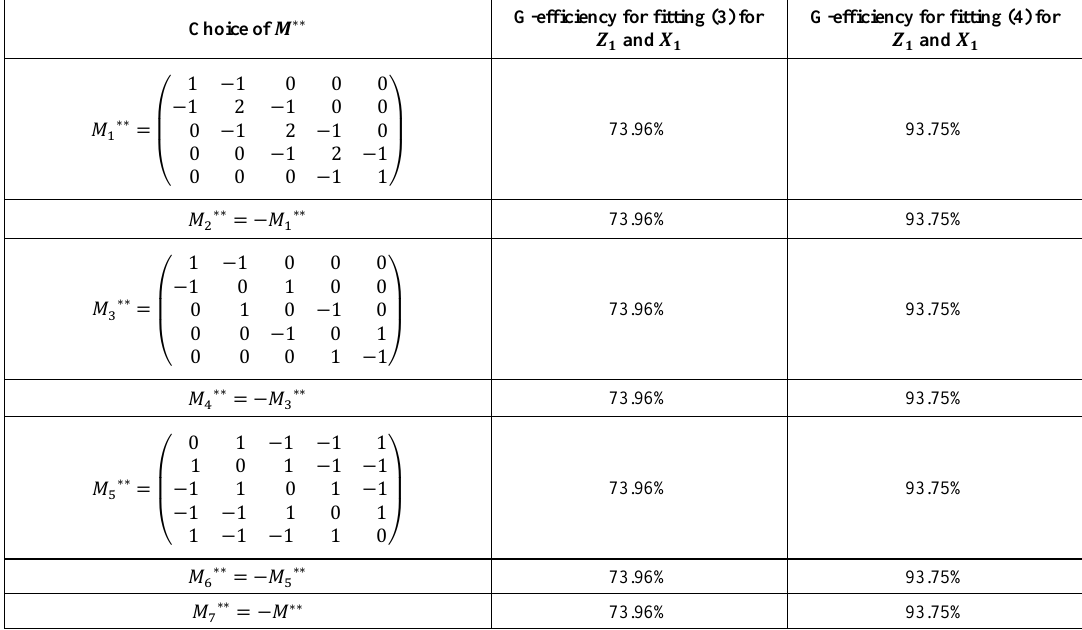
Table 3. G-efficiency of unconstrained and constrained mixture designs corresponding to different choices of 𝑀 ∗∗ for fitting Scheffé’s canonical polynomials G-efficiency for fitting (3) for G-efficiency for fitting (4) for Choice of 𝑴 ∗∗ 𝒁 𝟏 and 𝑿 𝟏